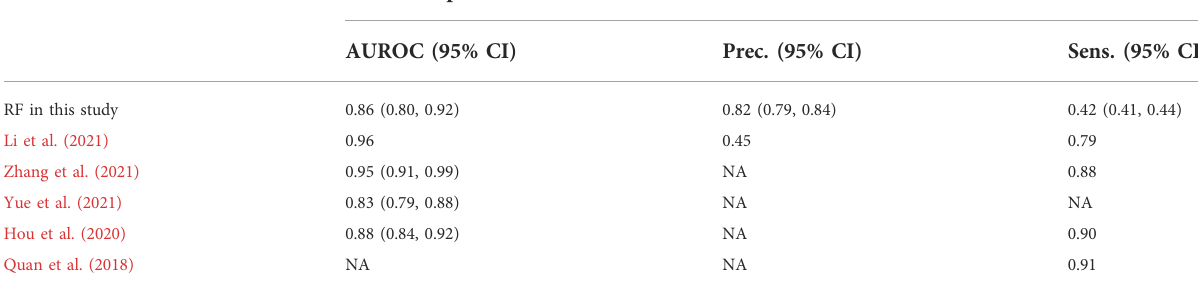
TABLE 4 Predictive performances shown by DNN models in this study compared to those from previous